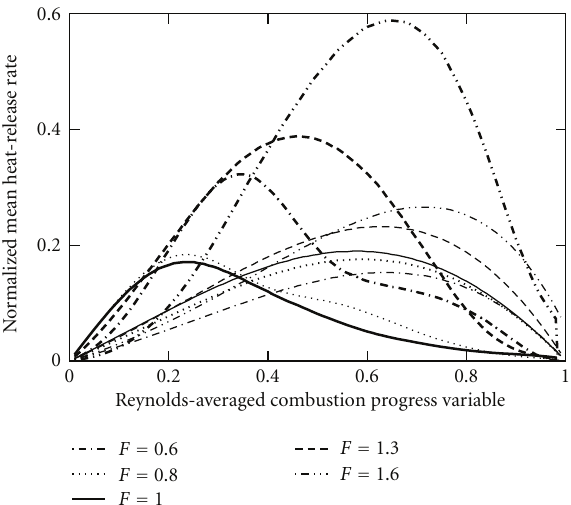
Figure 6: Dependencies of the normalized mean heat release rate on the Reynolds-averaged combustion progress variable, calculated for various equivalence ratios specified in legends and g = 0 . 5 using the beta-function PDF (thin curves) and the 2 δ -PDF (bold curves).